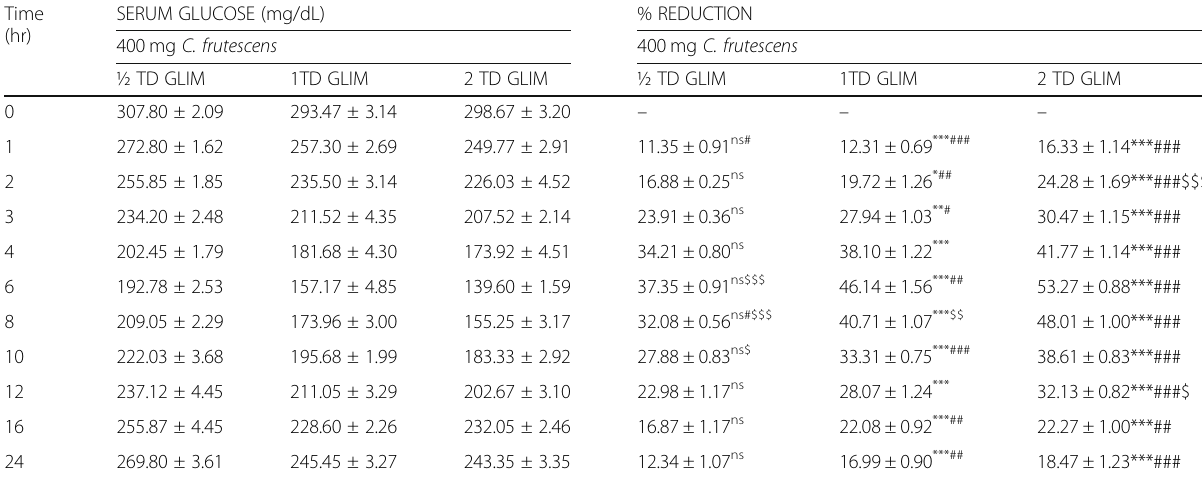
Table 4 Influence of repeated dose treatment of C. frutescens (400 mg/kg) on antidiabetic activity of glimepiride in diabetic rats (8th